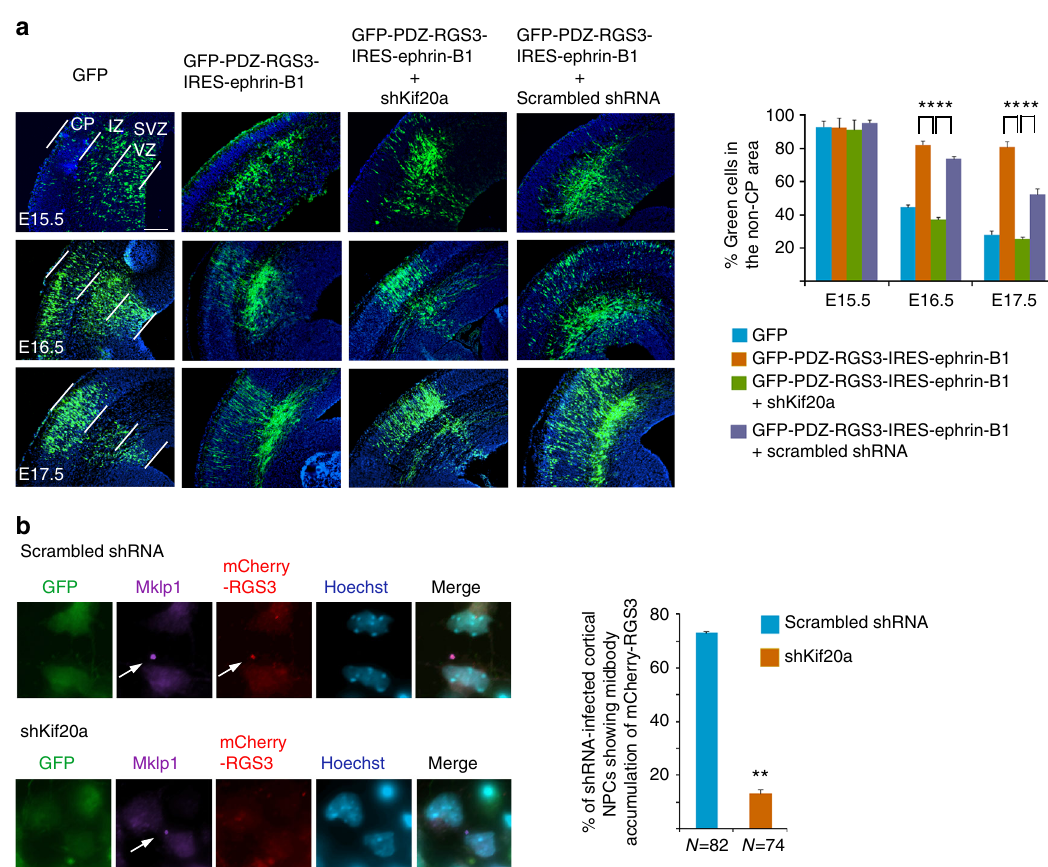
Fig. 4 KIF20A works in coordination with the Ephrin-B – RGS complex in NPCs. a DNA plasmids were electroporated into the cortex at E13.5 and brains were analyzed at E15.5, E16.5, and E17.5. Distributions of transfected cells in the non-CP regions (IZ, SVZ, and VZ) were scored (5 – 8 electroporated brains for each plasmid or combination of plasmids were used for quanti fi cation). ** P < 0.01 comparing rescue by shKif20a to controls. Error bars represent SD. Scale bar represents 100 μ m. b Dissociated cells from the E13.5 cortices were co-infected with lentiviruses for expression of mCherry-RGS3/scrambled shRNA or mCherry-RGS3/shKif20a. After culturing for 2 days post infection, cells were fi xed and stained with anti-KIF23/MKLP1 antibody. Percentage of telophase NPCs (with noticeable midbody localization of MKLP1, indicated by white arrows) showing midbody accumulation of mCherry-RGS3 was scored. ** P < 0.01 (Student's t